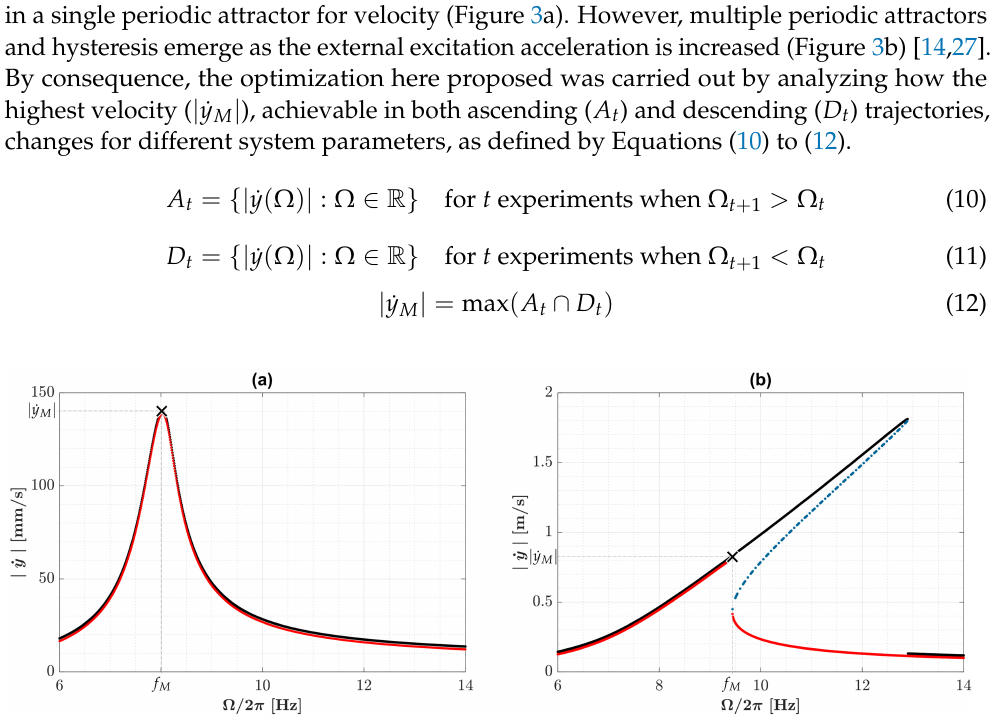
Figure 3. Relative velocity response for ∆ d = 0, R l = 1 M Ω and the following excitation amplitudes: ( a ) 0.5 m/s 2 and ( b ) 4 m/s 2 . The behavior due to the non-linear phenomenon for upward ( A t ) and downward ( D t ) frequency sweeps is identified by the black and red solid lines, respectively (stable periodic solutions), while the blue dashed line illustrates unstable periodic solutions; the maximum velocities considered ( | ˙ y M | ) are identified with black